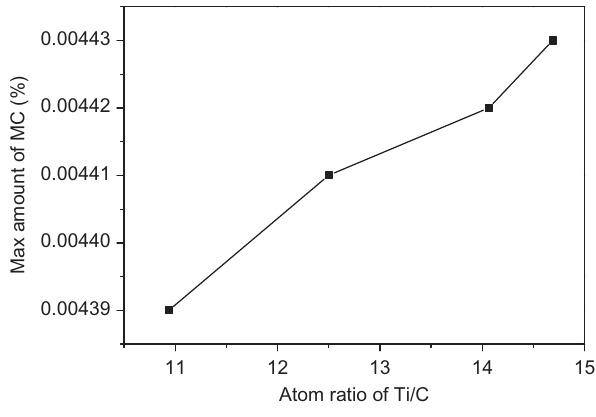
Figure 15: Influence of Ti/C on maximum amount of MC.